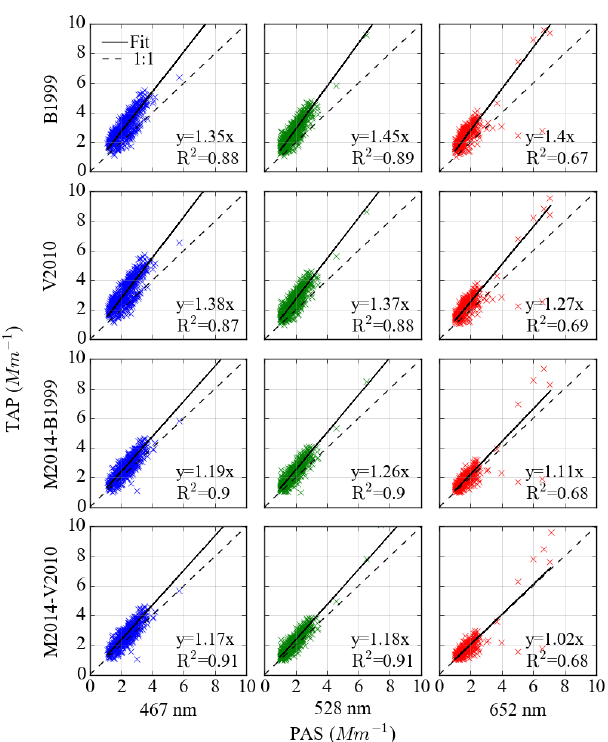
Figure 3. Absorption coefficients measured by PAS versus TAP for urban emissions around London in July 2017. The columns corre- spond to 467nm (column 1), 528nm (column 2), and 652nm (col- umn 3) wavelengths, and the rows correspond to the B1999, V2010 and M2014 corrections. All absorption coefficients correspond to >1Mm − 1 . All linear regressions were forced through the